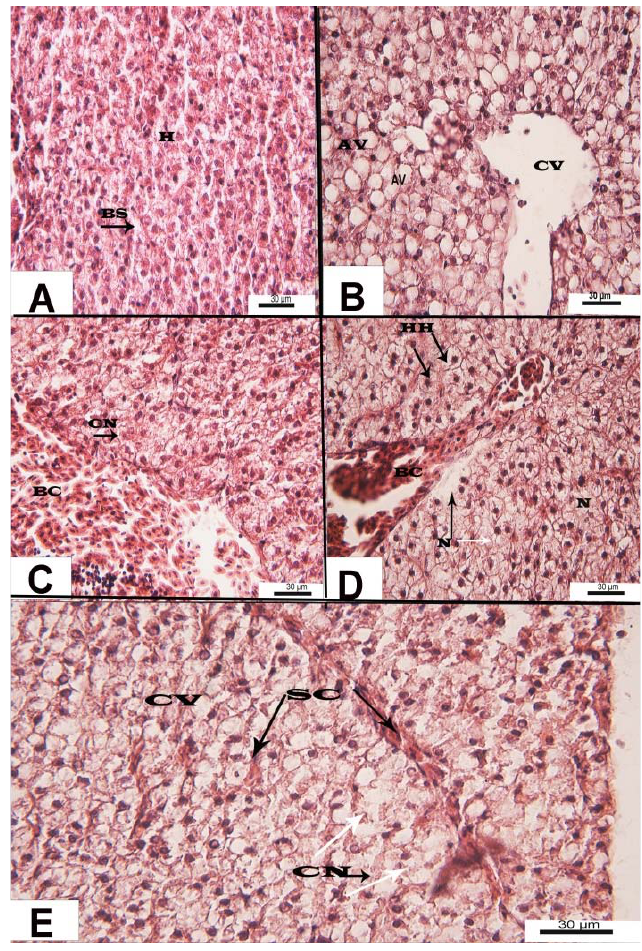
Fig. 3: Micrographs of the liver of Caspian roach (Stained by Hematoxilin and Eosin) [A] Normal liver tissue, hepatocytes (He), Blood sinusoid